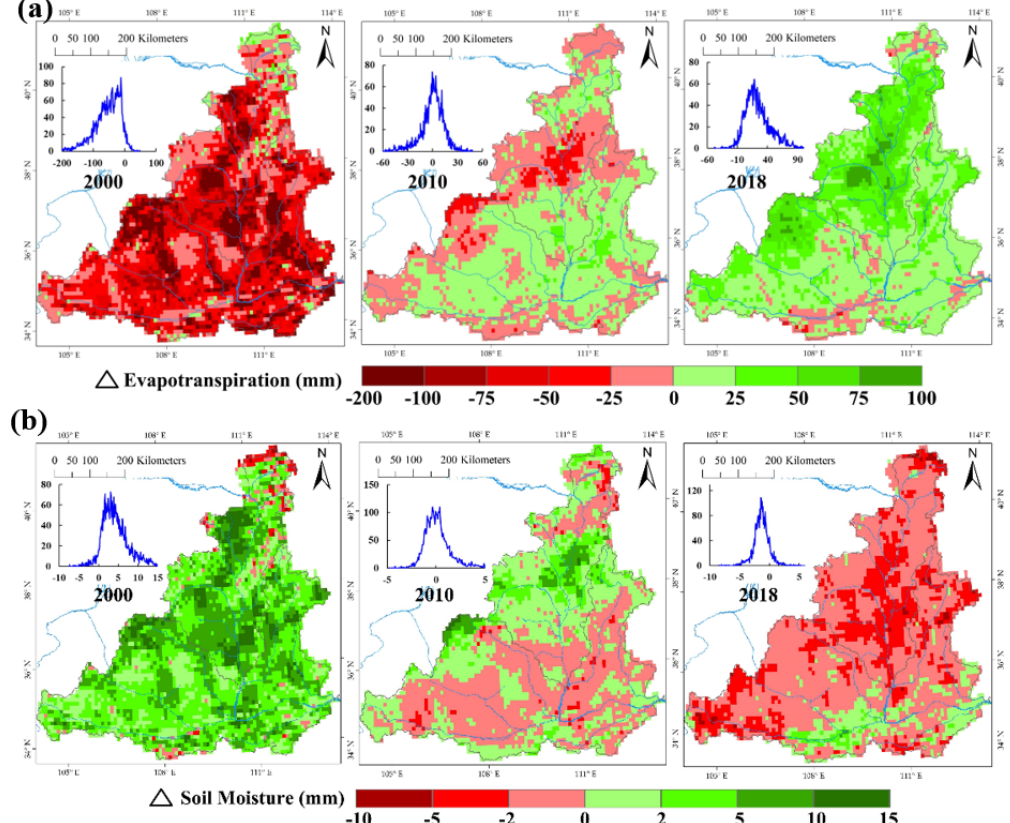
Figure 13. The difference between two simulations by VIC with dynamic LAI and fixed multiyear average LAI during 2000–2018 for annual total evapotranspiration (a) and annual average soil moisture (b) in the middle reaches in the year of 2000, 2010 and 2018. The insets show the statistical histogram of the difference